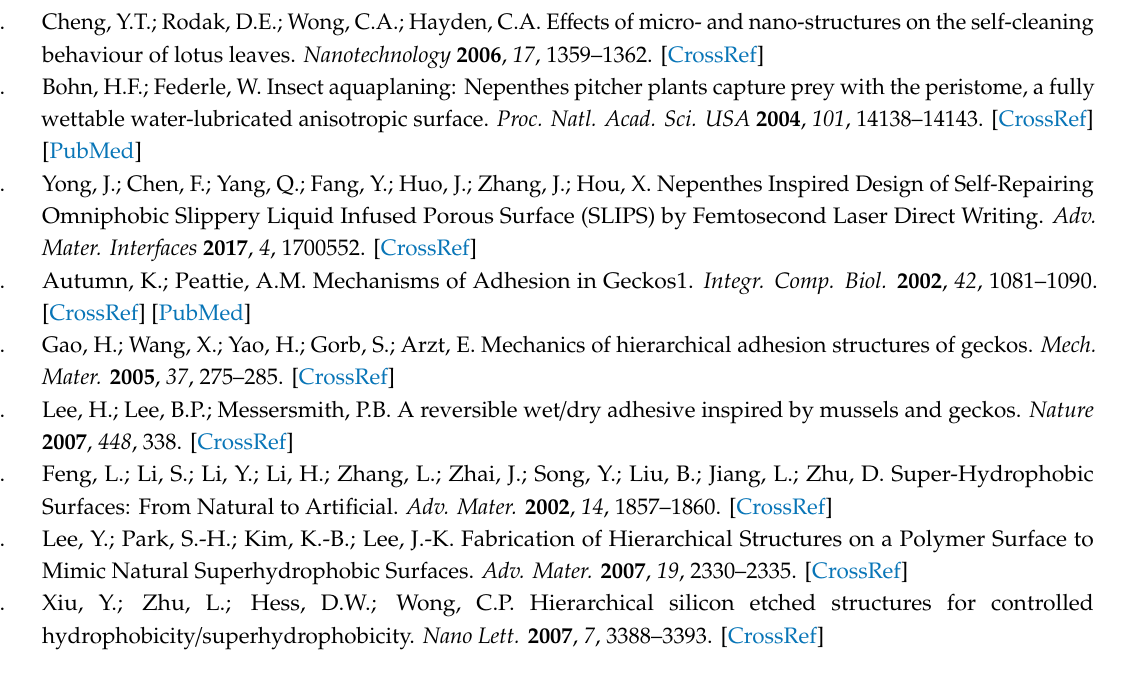
Figure S1: Schematic fabrication process with solvent-assisted UV-lasering; Figure S2: Various surfaces with self-similar structures; Figure S3: Surface morphology of cPDMS; Figure S4: EDX map of black Si samples; Figure S5: Light absorbance curves of black Si samples with di ff erent parameters; Figure S6: Heating features of various samples; Figure S7: Detailed fabrication process of soft substrate (PDMS) with water / liquid alloy amphiphilic areas; Figure S8: Micro-views of Si master and replicated PDMS substrates; Figure S9: Superhydrophilicity of Si with self-similar structures; Figure S10: Radar plot of comparison our approach with others; Video 1: Superhydrophilicity of black silicon